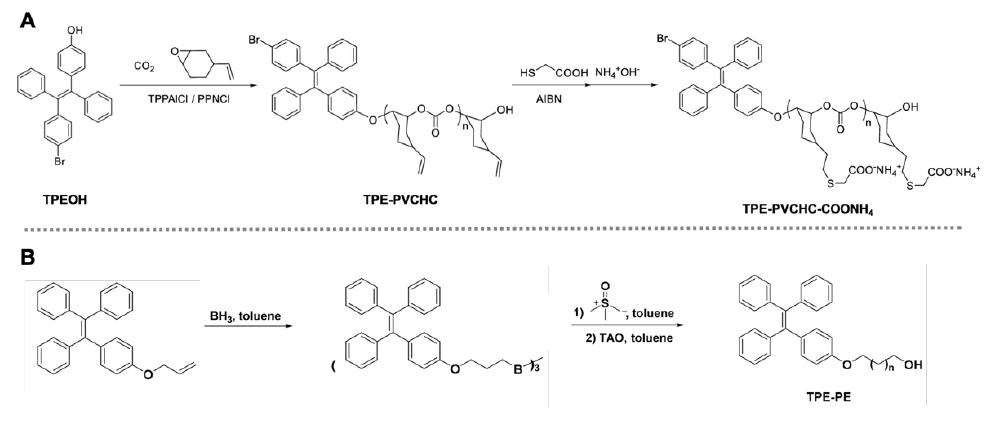
Figure 5. Synthesis of TPE-based polycarbonate ( A ) [88] and PE ( B ) [95].